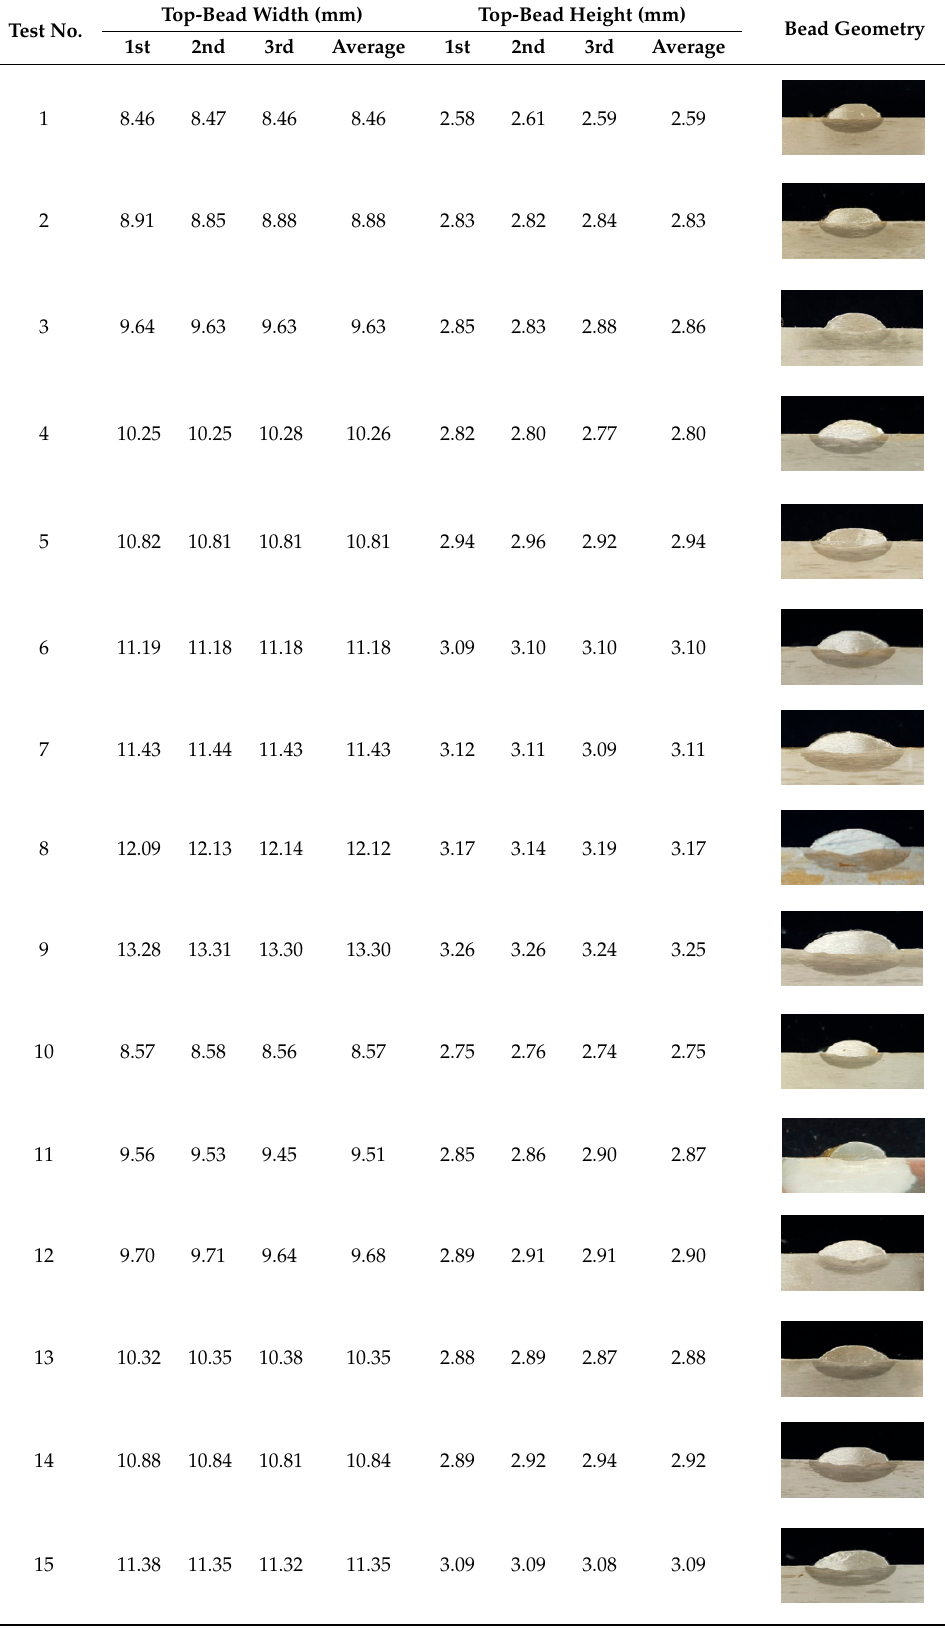
Table 5. Dimensions of bead of flux-cored arc welding experiment. Test No.